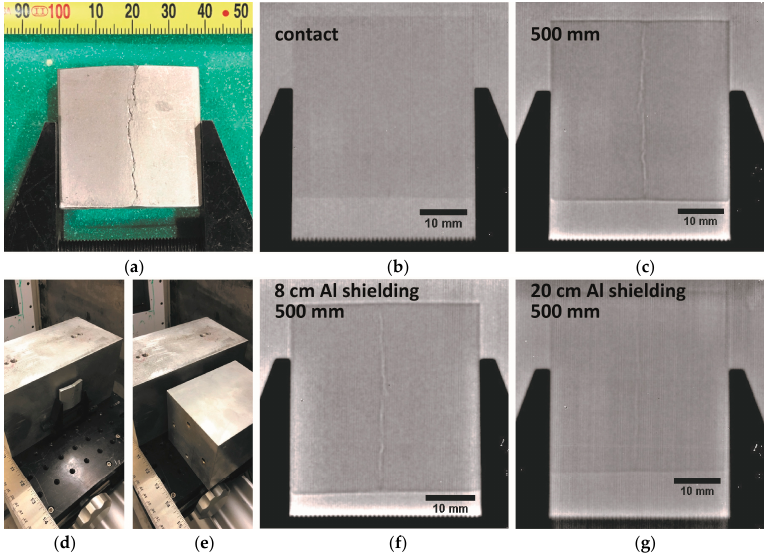
Figure 23. Cold neutron imaging of a hairline crack in an Al plate. ( a ) Photograph of cracked Al plate ( b ) cold neutron radiograph, 10 minutes exposure ( c ) phase contrast image using the propagation method, 10 minutes exposure. Bottom, ( d,e ) photos of the cracked plate between 20 cm of Al shielding ( f ) PCI of the plate inside 8 cm of Al shielding, 20 minutes exposure ( g ) PCI of the plate inside 20 cm of Al shielding, 25 minutes exposure. The neutron images were taken with a 6 Li-ZnS:Ag phosphor on an aluminum backing coupled to an a-Si flat panel detector.